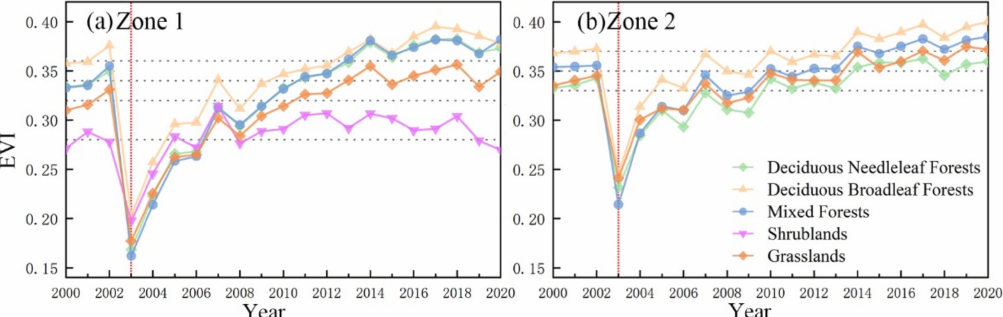
Figure 7. Time series of enhanced vegetation index under different vegetation types. ( a ) In the first study area of Northeast China in 2003; ( b ) in the second study area of Northeast China in 2003. The gray dashed line is the mean reference line for each vegetation type in the three years pre-fire. The horizontal axis is the year, and the vertical axis is the EVI value.